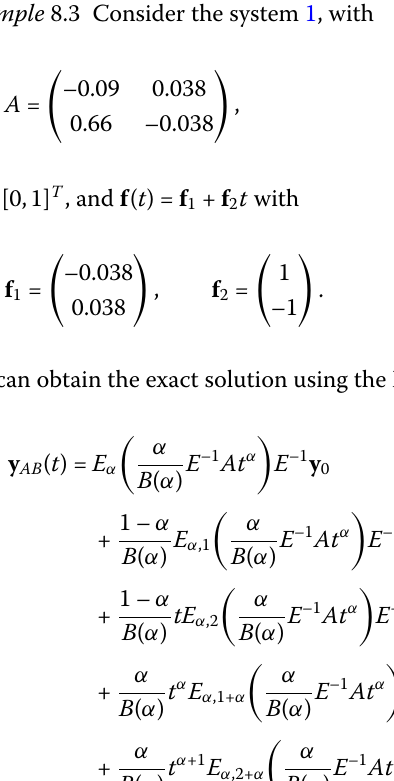
the approximate solution to be exact up to the floating point error. Tables 2 and 3 confirm this